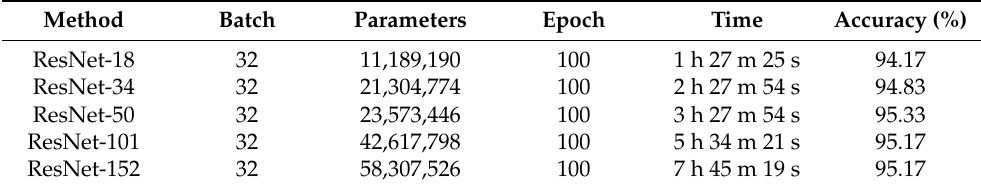
Table 1. Parameters and results of the training model.